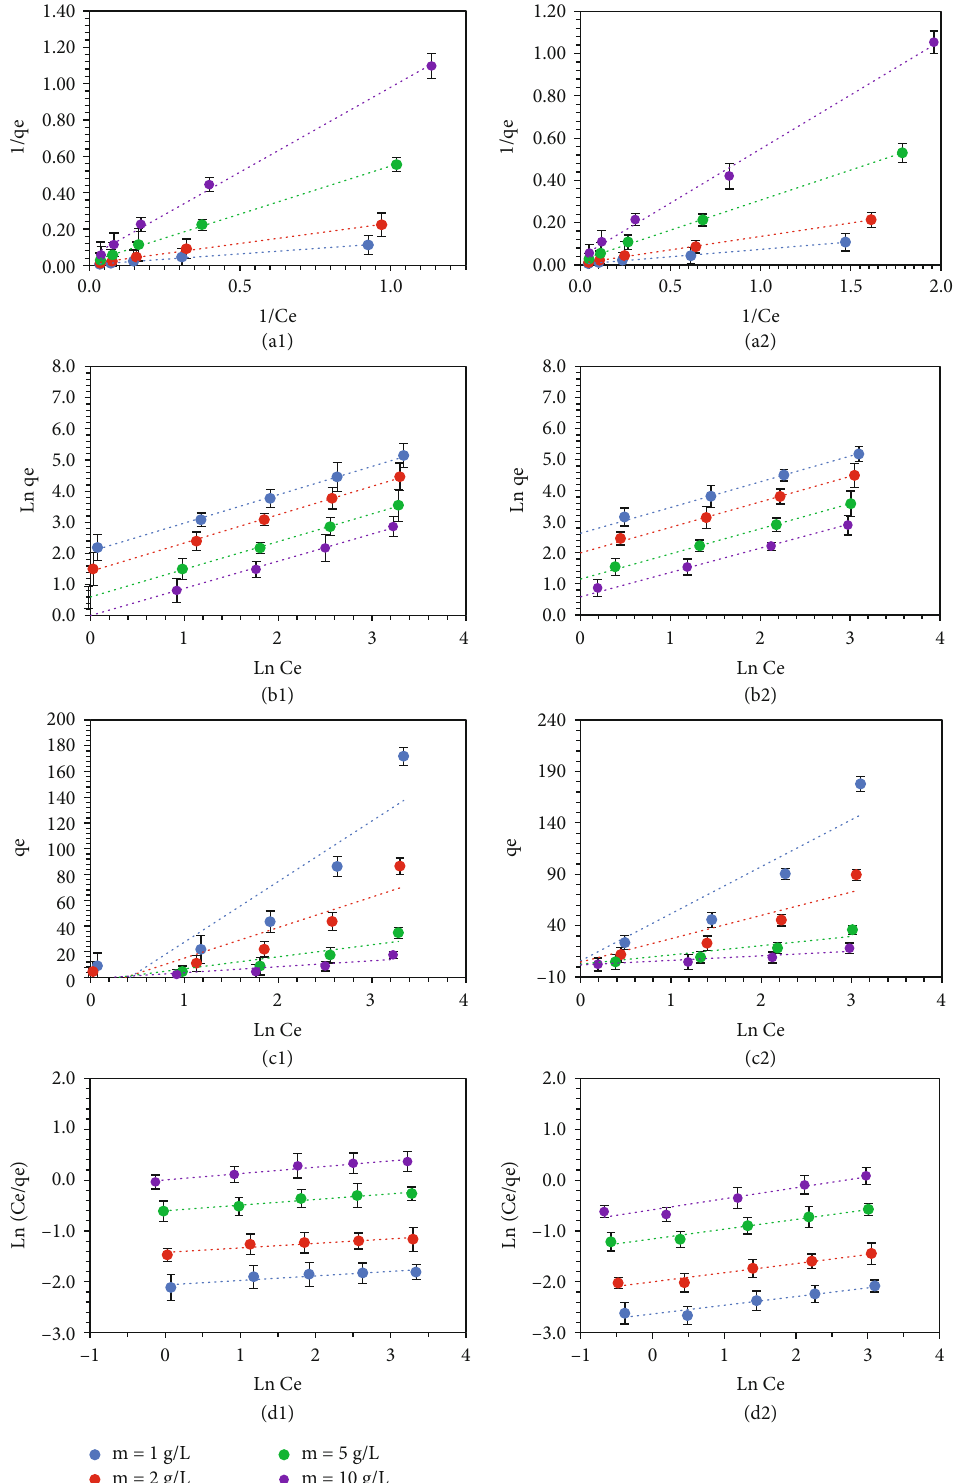
Figure 6: Langmuir, Freundlich, Temkin, and Redlich-Peterson isotherm model plots with linear estimation at 35 ° C, pH 5, and 200 rpm operating conditions for BS (a1, b1, c1, and d1, respectively) and MBS (a2, b2, c2, and d2, respectively). ± SD shown by error